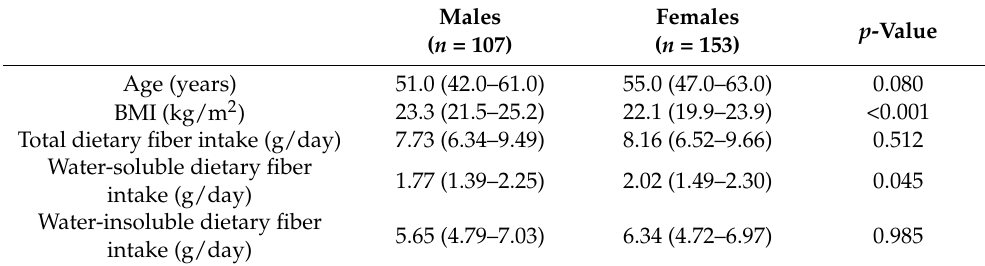
Table 3. Participants’ characteristics of Group L 1